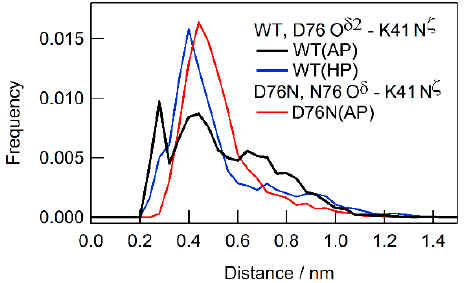
Figure 5. Distribution of distance between D76 and K41 side chains for WT at ambient pressure (WT(AP), black) and at 200 MPa (WT(HP), blue), respectively, while that between N76 and K41 side chains for D76N at ambient pressure (D76N(AP)) is indicated by a red line.